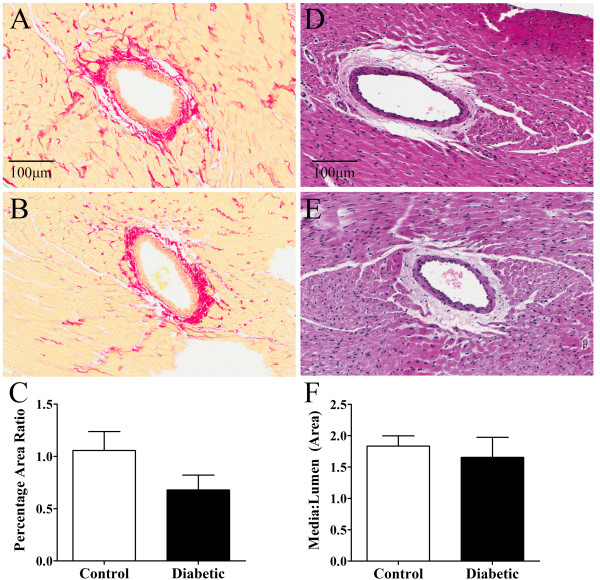
Myocardial perivascular fibrosis and media:lumen ratio in control and diabetic rats. Perivascular collagen ratio (C) was assessed via picrosirius red staining in control (A) and diabetic (B) rats (20× objective). Vessel media-to-lumen ratio (F) was assessed via haematoxylin and eosin staining in control (D) and diabetic (E) rats (20× objective). There was no significant difference between groups. Control, n = 6 and diabetic, n = 8. Values expressed as mean ± SEM.